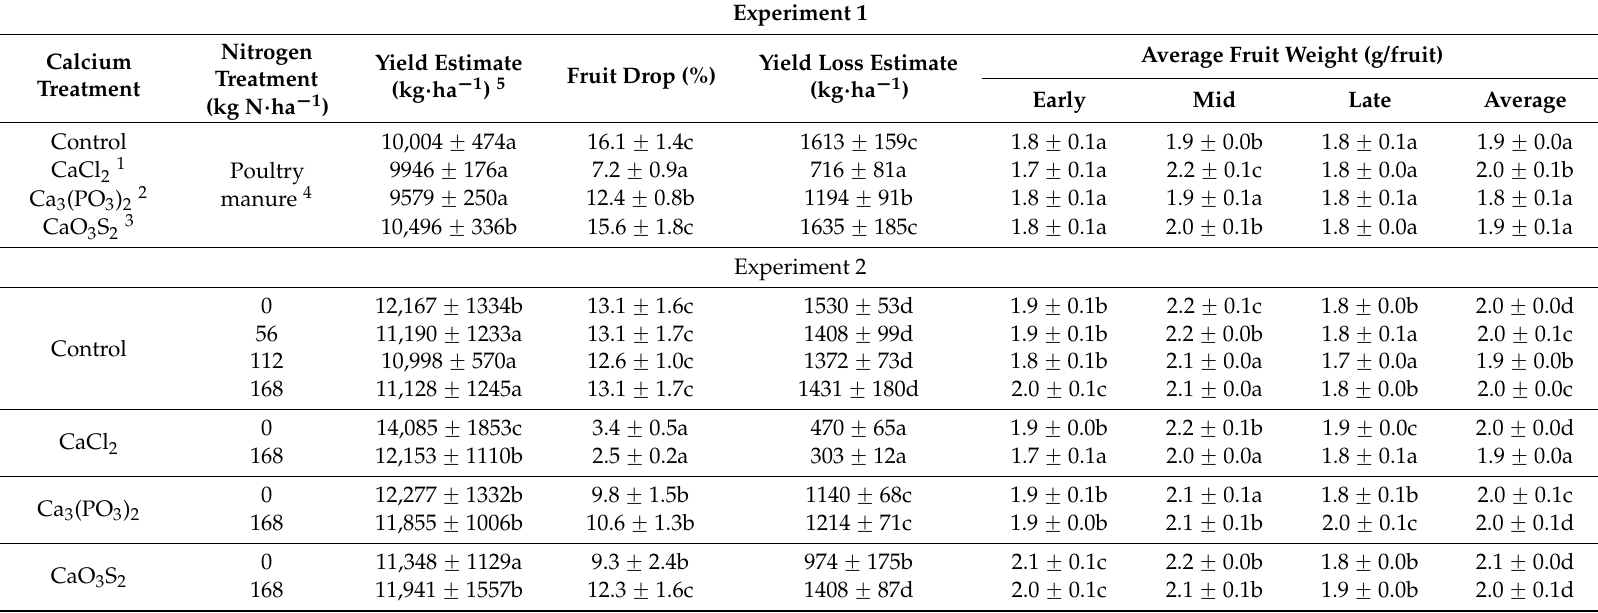
Table 2. Effects of foliar Ca treatments on mean ˘ SE estimated fruit yield, pre-mature green fruit drop, yield loss and fruit weight in ‘Draper’ highbush blueberry in Abbotsford, British Columbia, Canada in